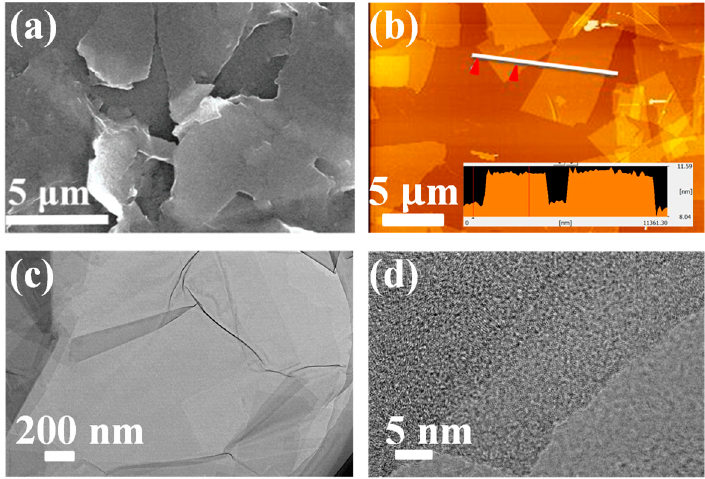
Figure 2. ( a ) Scanning electron microscopy (SEM), ( b ) atomic force microscopy (AFM), and ( c , d ) TEM images of K 4 Nb 6 O 17 nanosheets.